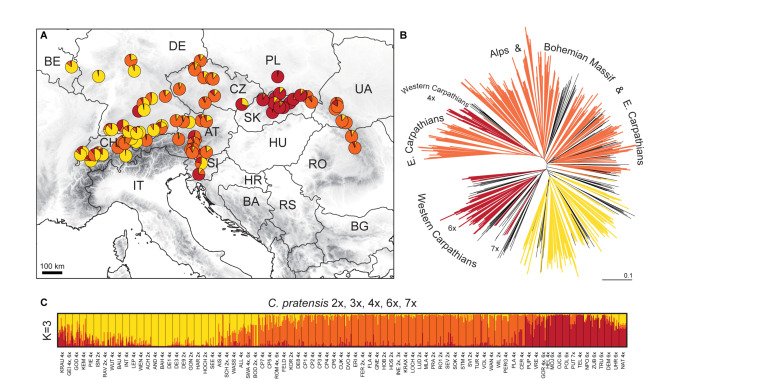
Genetic structure of Cardamine pratensis inferred from microsatellite data analyses of the Prat Matrix. (A) Distribution of sample sites. Different colors indicate the population assignment to three genetic clusters as inferred from STRUCTURE analyses. (B) Neighbor-joining tree diagram based on Lynch distances. Branches are colored according to the population assignment to three genetic clusters as inferred from STRUCTURE analyses; populations with equivocal (admixed) assignments are in black. (C) Bayesian model-based clustering (STRUCTURE) at K = 3. The coloring of vertical bars indicates each individual’s proportional cluster assignment: yellow: Western lineage; orange: Alpine-Bohemian-E Carpathian lineage; red: W Carpathian lineage. The ploidy level of each population is also indicated. For locality codes see Supplementary Data 1.